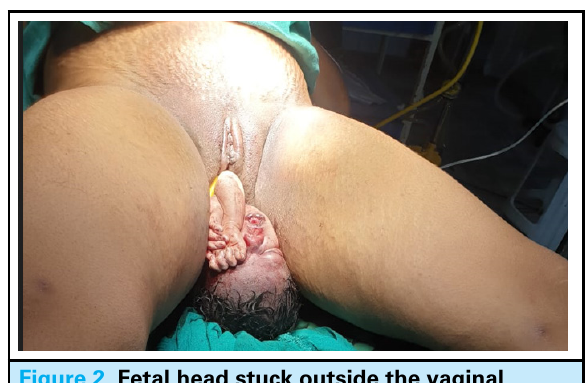
Figure 2. Fetal head stuck outside the vaginal introitus.